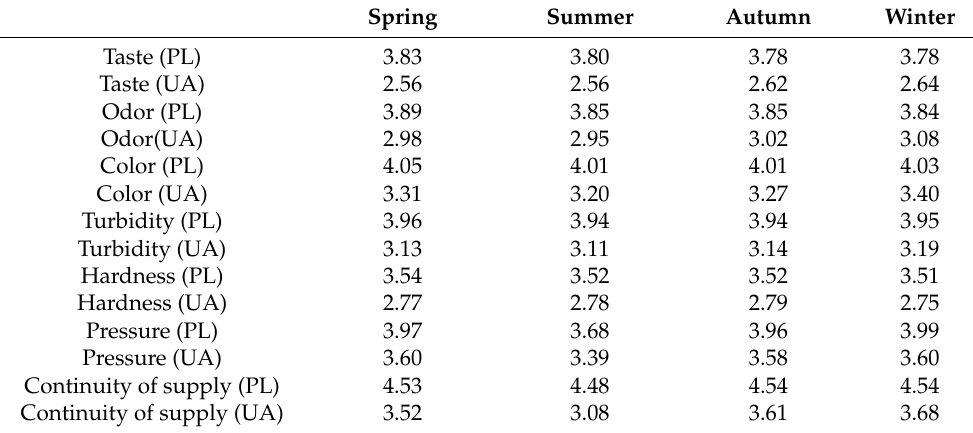
Table 16. Average ratings of parameters of tap water supplied in Poland and Ukraine for individual periods of the